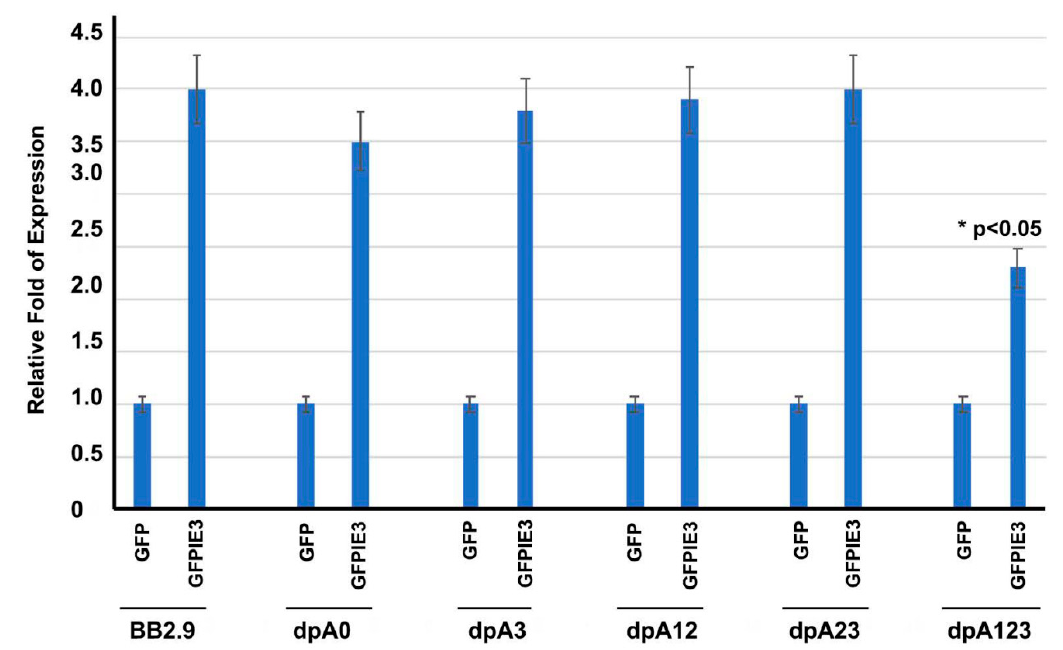
Figure 3. RT-qPCR assay to determine the activation of M112-113 by IE3. The M112-113 plasmids were cotransfected with either GFP- or GFPIE3-expressing plasmid into NIH3T3 cells for 24 h. The total RNA was isolated for an RT-qPCR assay using primers for M112-113 or GAPDH to examine mRNA levels. The M112-113 mRNA levels were first normalized with GAPDH and then compared between the GFPIE3 group and the GFP group. The ratios from 3 independent experiments are shown as a bar graph. A Student’s t -test was applied to statistically analyze the data, and significance was only seen for the group of dpA123 when compared to other groups: * p < 0.05.